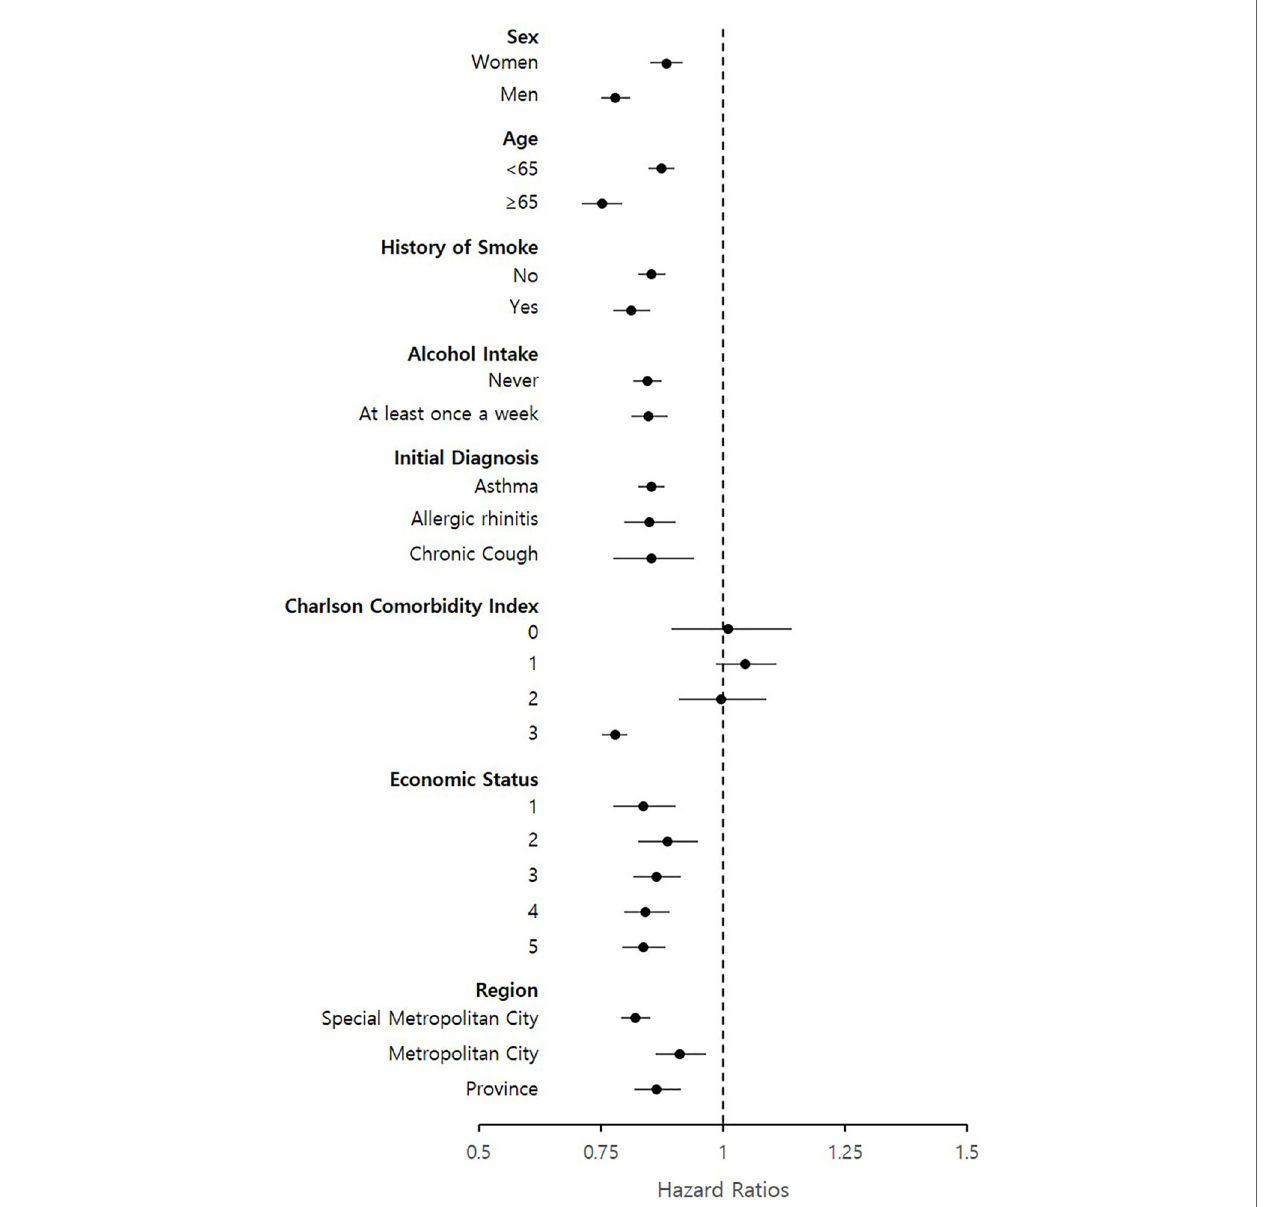
FIGURE 2 | Subgroup analysis of hazard ratios for cancer events based on patient ’ s sex, age history of smoke, alcohol intake, initial diagnosis, charlson comorbidity index, economic status and